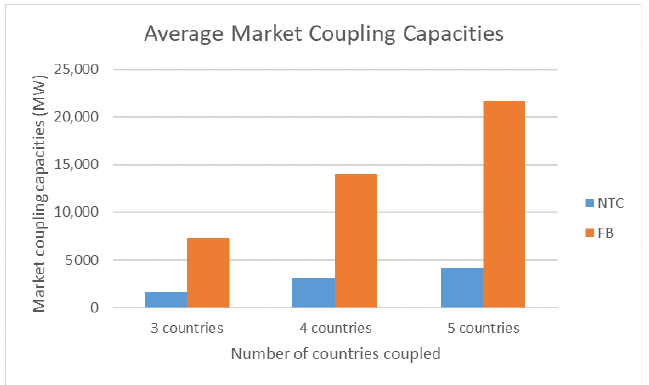
Figure 8. Average market coupling capacities index via both approaches.